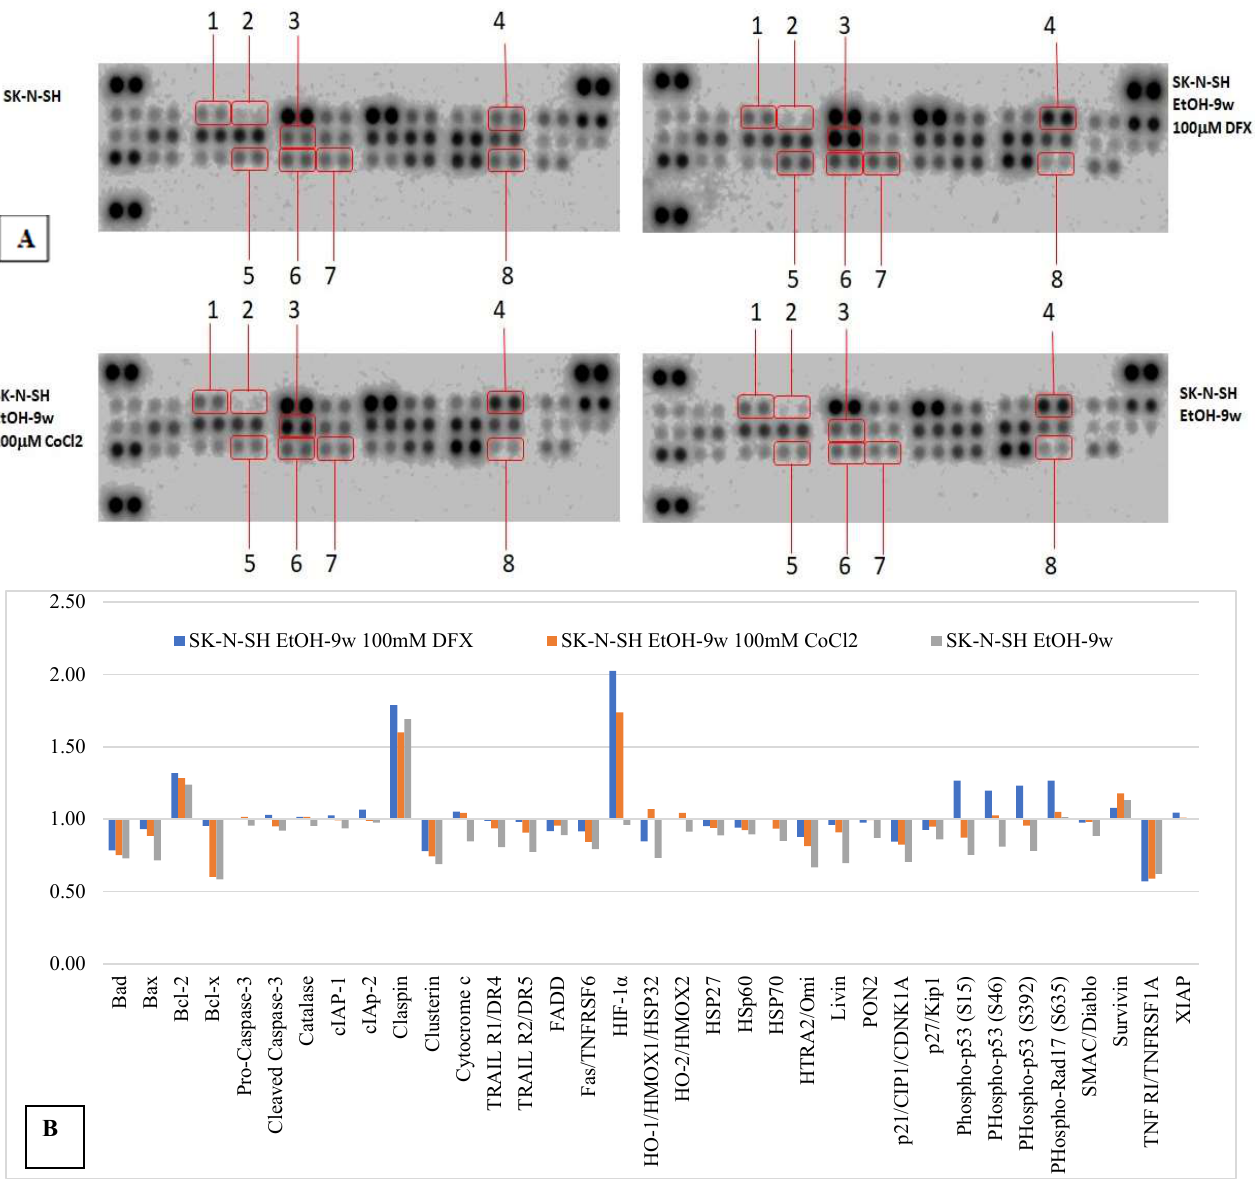
Figure 5. The effects of hypoxia mimetic treatment on apoptosis-related proteins in chronic ethanol- treated SK-N-SH cells. The total protein lysates (400 μg) were subjected to proteome profiler array analysis. ( A ) Dot-blot image: 1. Bcl-2; 2. Bcl-x; 3. HIF-1α; 4. Claspin; 5. Phospho-p53 (S15); 6. Phospho-p53 (S46); 7. Phospho-p53 (S392); 8. TNF RI/TNFRSF1A. ( B ) Fold change compared to ethanol- unexposed cells (logarithmic scale). The intensity of each spot was quantified using ImageJ software, and the resulted graph shows fold change of proteins measured after hypoxic treatment relative to untreated ethanol-unexposed control cells. Apoptotic cell death receptors and adapters (TRAILR1 (DR4), TRAILR2 (DR5), FADD, Fas, and OMI/HTRA2), the inactive form of caspase-3 (pro-caspase-3) and cleaved caspase-3, as well as apoptosis inhibitory proteins (cIAP-1, cIAP-2, and Livin), a small mitochondria-derived activator of caspases/direct inhibitor of apoptosis-binding protein with low pI (SMAC/DIABLO), and cytochrome C (component element of the apopto- some), were very weakly affected by both chronic alcohol treatment and hypoxic agents.